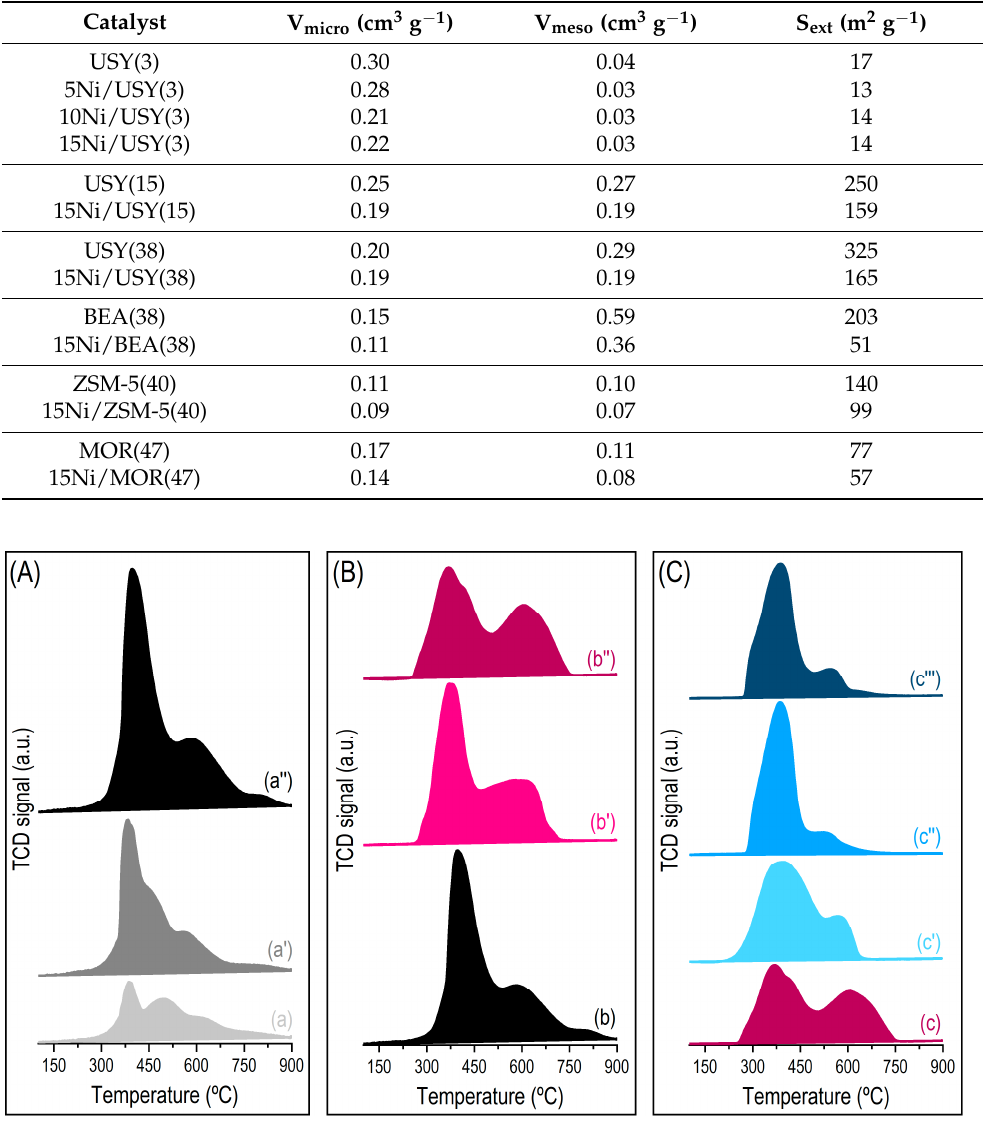
Table 2. Textural properties obtained using N 2 sorption for all the samples from the present work and the corresponding supports.